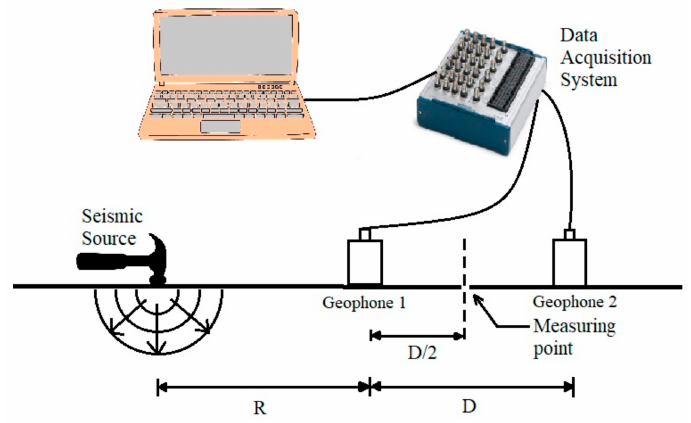
Figure 8. SASW method.